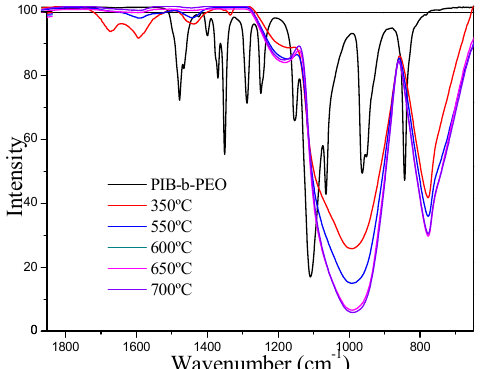
Figure 6. FTIR spectra of mesoporous Li 4 Ti 5 O 12 thin films heat-treated at different temperatures and PBI-b-PEO block copolymer for comparison.